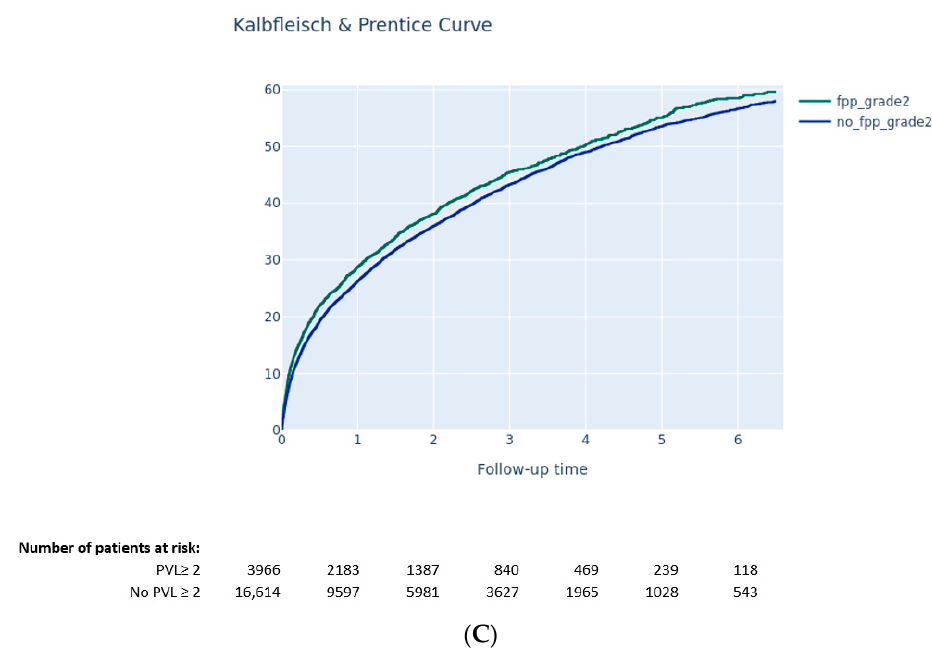
Figure 5. ( A ) Cumulative incidence of occurrence of first hospitalization for heart failure according to the presence of grade ≥ 2 paravalvular leak (Kalbfleisch and Prentice curve). ( B ) Cumulative incidence of occurrence of aortic valve reintervention according to the presence of grade ≥ 2 paravalvular leak (Kalbfleisch and Prentice curve). ( C ) Cumulative incidence of arrythmia according to the presence of grade ≥ 2 paravalvular leak (Kalbfleisch and Prentice curve).